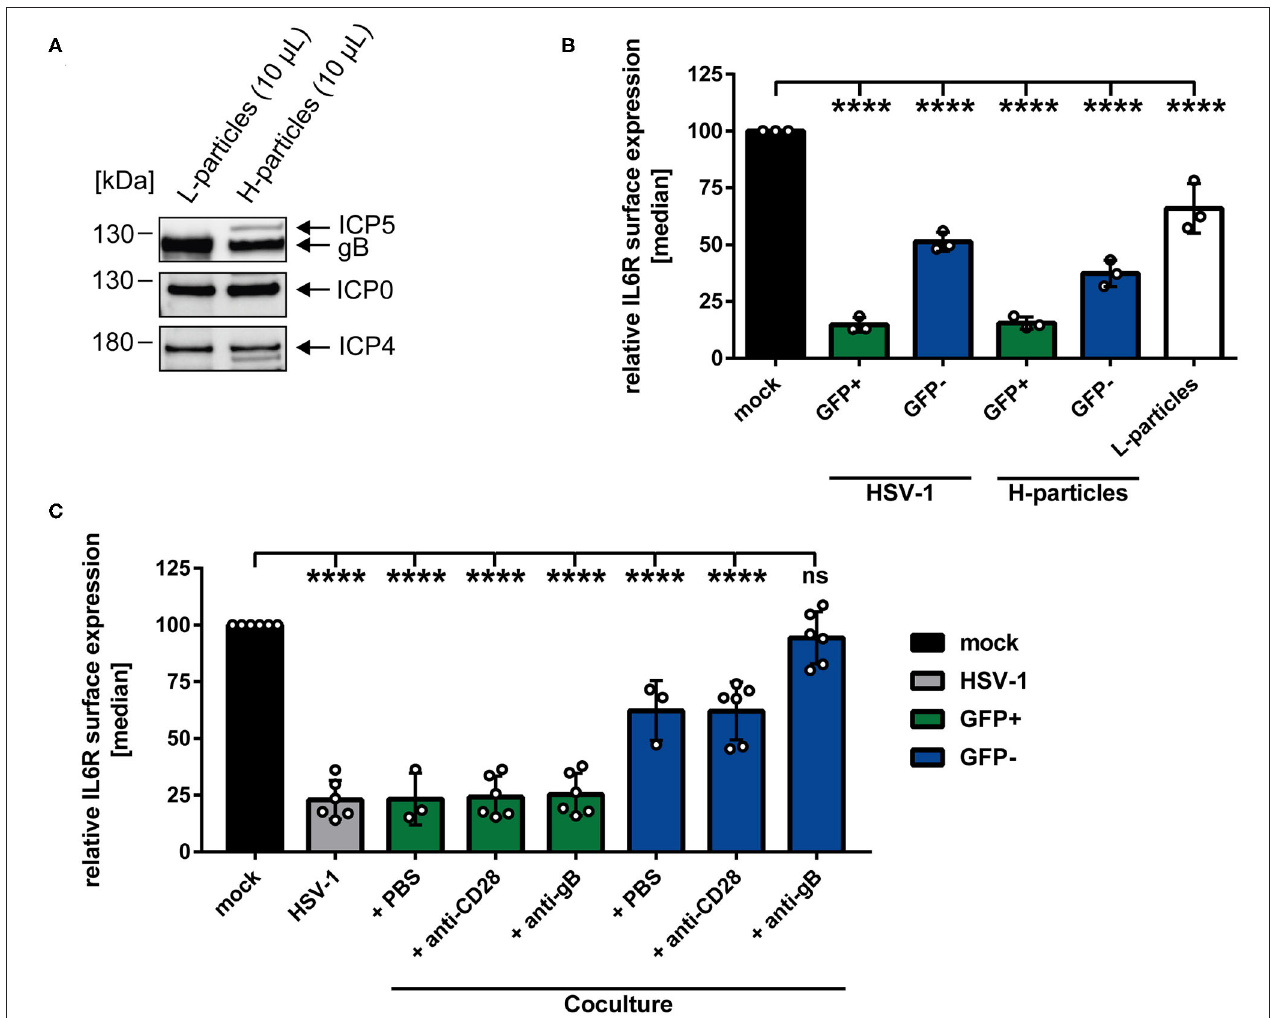
FIGURE 5 | HSV-1-mediated IL6R modulation is transmittable via L-particles from directly-infected GFP-positive to uninfected GFP-negative bystander mDCs. (A) Western blot analyses of purified L- and H-particles derived from BHK21 cells. Antibodies specific for ICP0, ICP4, ICP5 and gB were used. One exemplary experiment out of ten is shown. (B) Mature DCs were either infected with HSV-1 wt (MOI of 0.65), purified H-particles (MOI of 0.65) or treated with L-particles (viral material corresponding to high MOI, irradiated three times applying 0.12 J/cm 2 , white bar). Cells were harvested 24 hpi and analyzed for their IL6R surface expression via flow cytometry. The experiment was performed three times with cells derived from different healthy donors. (C) Mature DCs were mock- or HSV-1 wt-infected (MOI of 5) and all samples were trypsinized at 3 hpi. Subsequently, infected cells were cocultured with uninfected mDCs in the presence of an anti-gB specific antibody, an anti-CD28 control antibody or PBS (ctrl) at 6 hpi. HSV-1 wt-infected mDCs, cultured for 24h, were included as a positive control (“HSV-1,” gray bar). Cells were harvested 24 hpi and stained with an IL6R-specific antibody and analyzed by flow cytometry. GFP-positive directly-infected mDCs (green bars) and GFP-negative uninfected bystander mDCs (blue bars) in the coculture are depicted for each condition. The experiment was performed three to six times with cells from different donors. (B,C) Distinction between infected and uninfected mDCs is based on the GFP signal and the used gates in data evaluation software FCS Express 5, which are specific for either the GFP-positive or GFP-negative population. Error bars indicate SD. Significant changes to mock were analyzed using a one-way ANOVA and Bonferroni multiple comparison post hoc tests and are indicated by asterisks (**** p ≤ 0.0001).